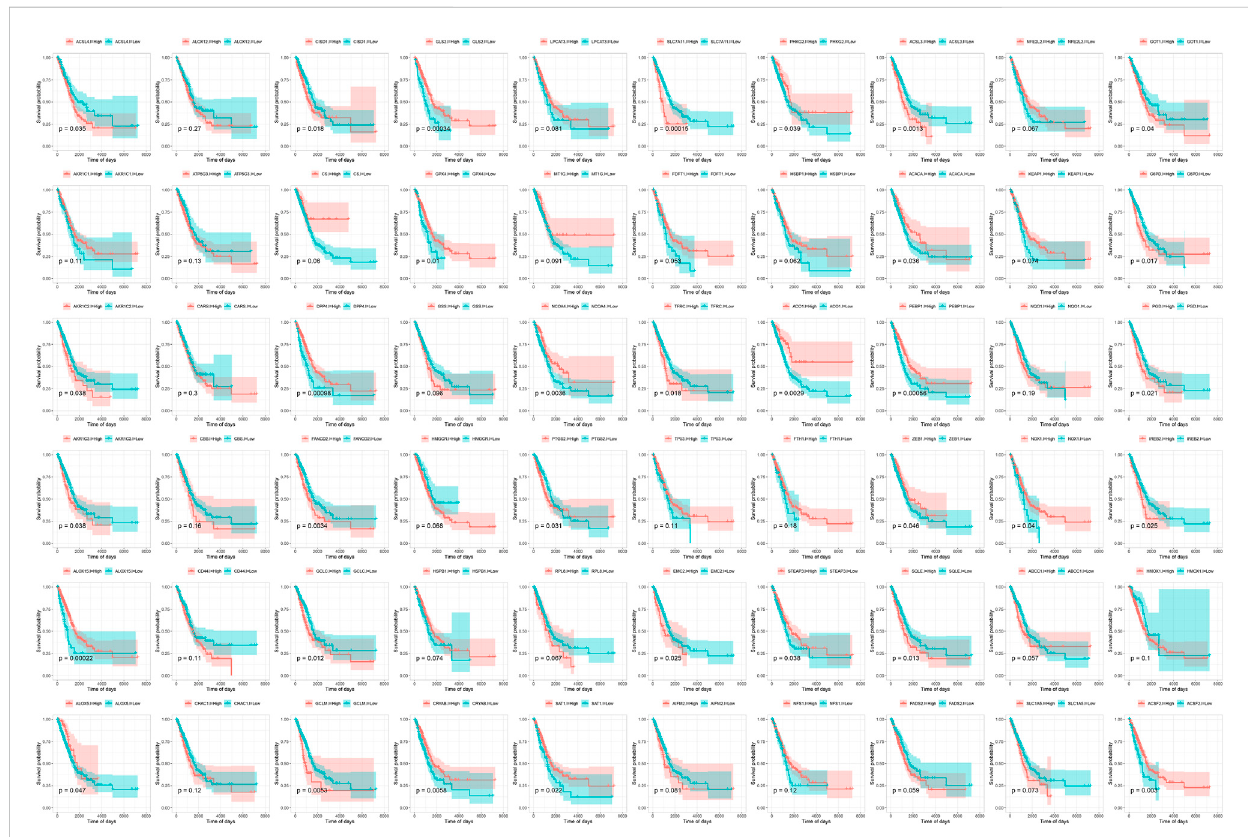
FIGURE 2 Survival curve of 60 ferroptosis-related genes and overall survival in the TCGA-LUAD data